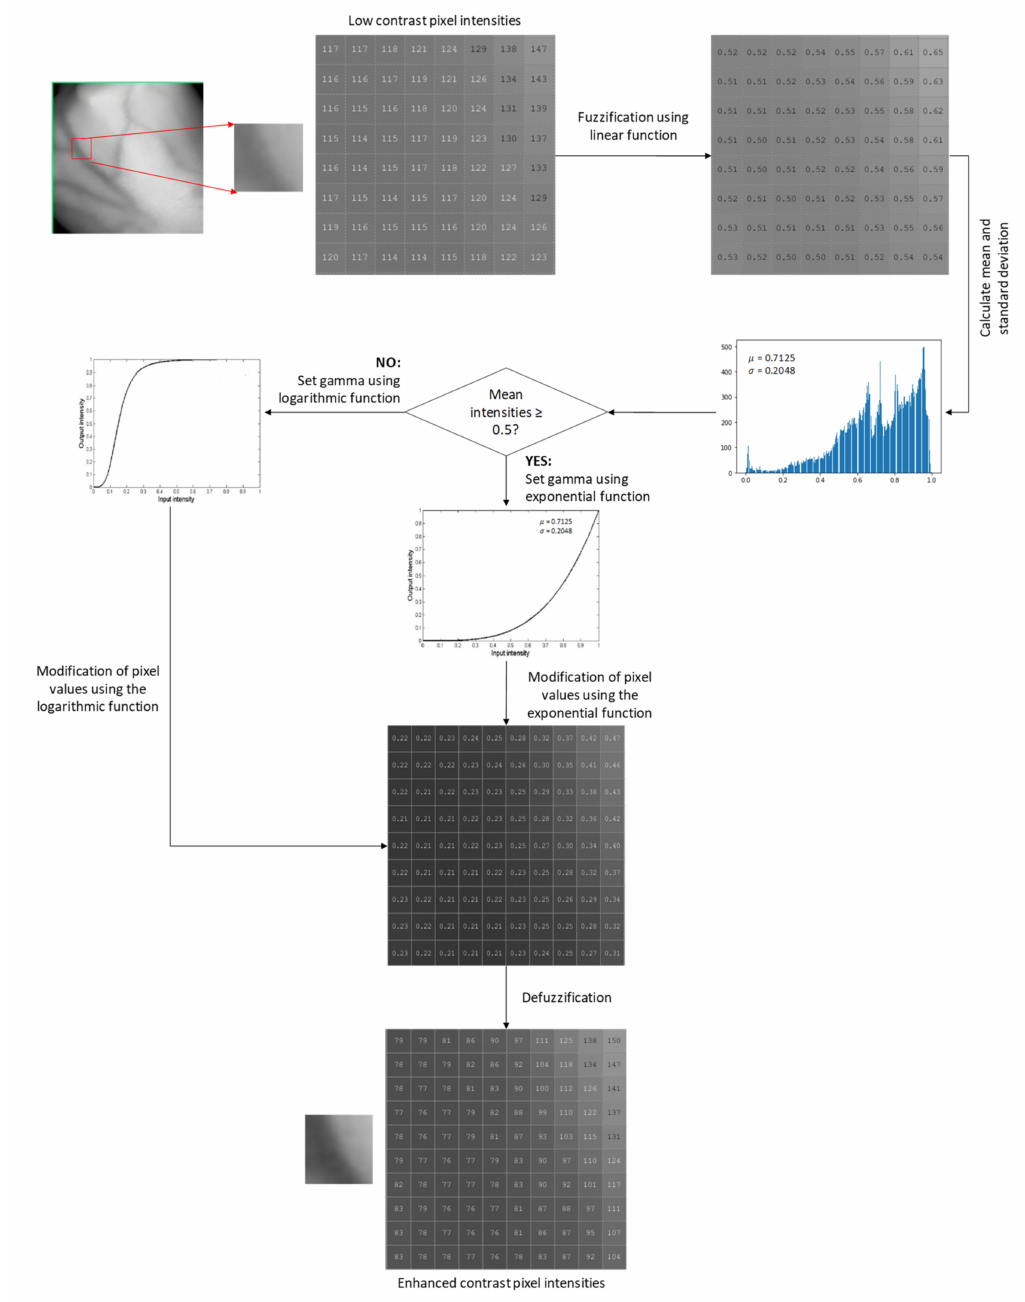
Figure 3. The procedures for the proposed FAG on a small part of vein